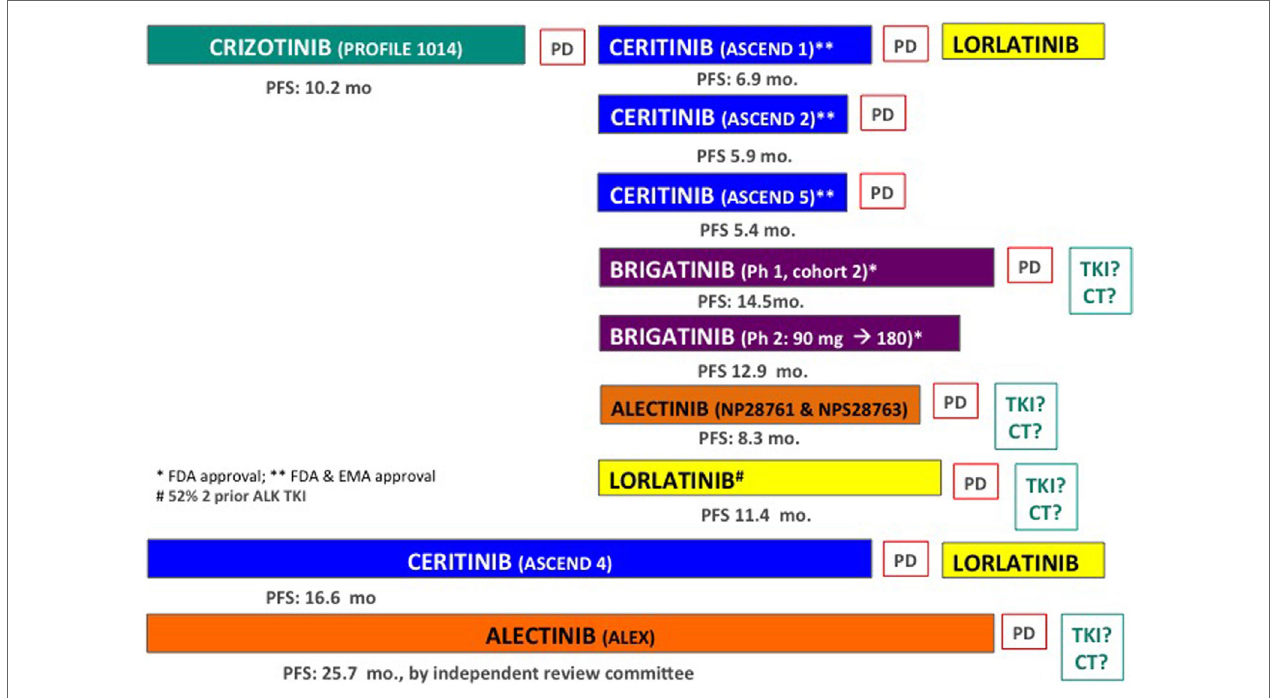
FiGURe 1 | Systematic treatment stratergies in ALK -positive non-small cell lung cancer (NSCLC) patients. TKI, other ALK tyrosine kinase inhibitor; CT,